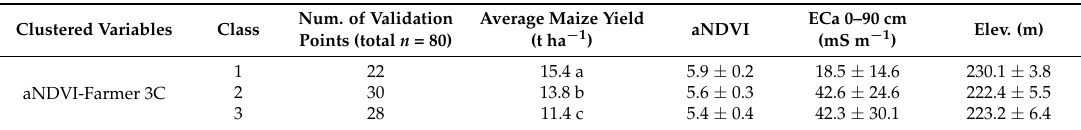
Table 6. Analysis of variance (ANOVA) of maize yield according to PMZs (aNDVI-Farmer 3C map) arising from the farmer’s expert modification of the original map of two accumulated NDVI classes. Clustered